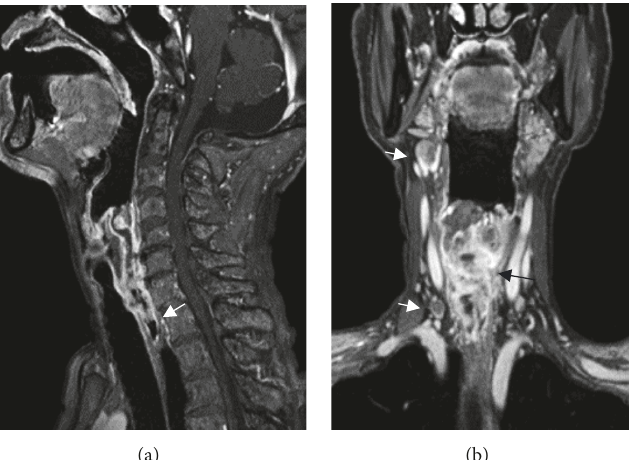
Figure 4: Preoperative cross-sectional MRI of the neck. (a) An enhanced sagittal image shows the tumor extending to the cervical esophagus (arrow). (b) An enhanced coronal image shows the large tumor completely occupying the hypopharyngeal space (black arrow). Note multiple lymph node metastases in the right neck (white arrows).